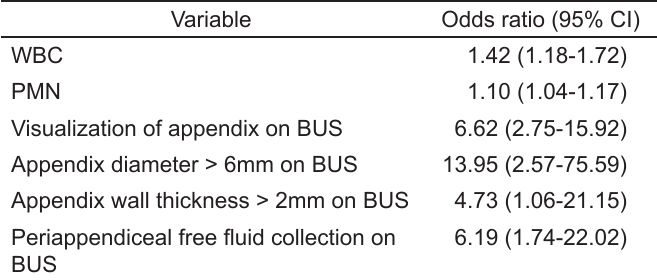
Table 5. Appendicitis predictor variables and their odds ratios on logistic regression of diagnostic bedside ultrasound (BUS)